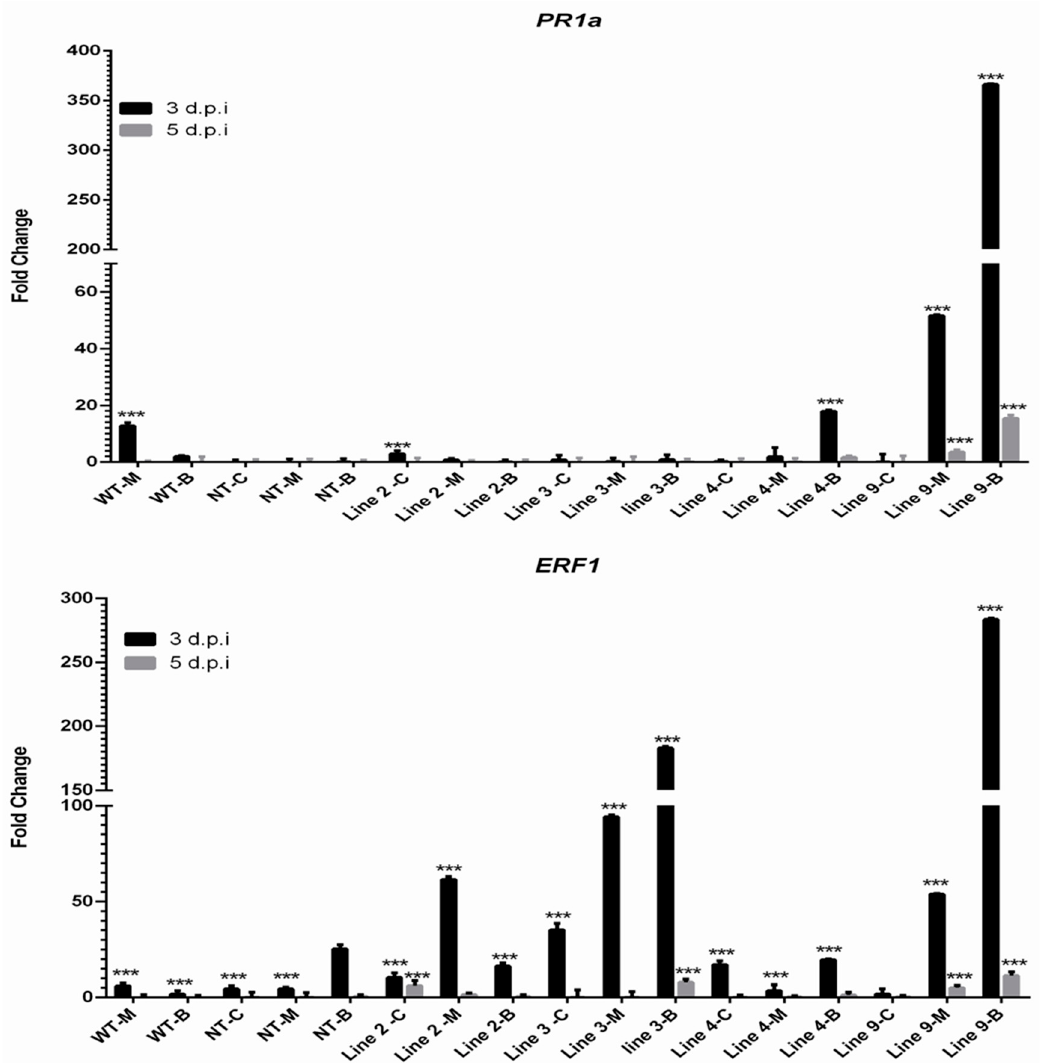
Figure 6. Transcript abundance of tobacco PR1a (above) and ERF1 (below) genes in different tobacco plants at 3 and 5 days post-inoculation with either non-treated control (C), either infected with B. cinerea (B), or mock treated with PDB (M). PR1a and ERF1 relative expression levels were determined as described earlier (Livak and Schmittgen 2001 [34]) and normalized with Elongation factor 1a ( EF-1a ). WT-M, untransformed wild-type tobacco mock treated with PDB; WT-B, untransformed wild-type tobacco infected with B. cinerea ; NT-C, non-transgenic tobacco non-treated control; NT-M, non-transgenic tobacco mock treated with PDB; NT-B, non-transgenic tobacco with independent transgenic tobacco infected with B. cinerea ; Line 2; Line 3; Line 4; Line 9, independent transgenic line expressing Sp-AMP2 with either non-treated control (C), infected with B. cinerea (B). or mock-treated with PDB (M). Data represent the fold change of Sp-AMP compared with expression in untreated wild type control plants at the corresponding time points. Error bars indicate the standard error of the mean across three independent biological replicates. Asterisks indicate the level of significance in comparison to non-transgenic plants infected with B. cinerea (NT-B), *** p values < 0.001.